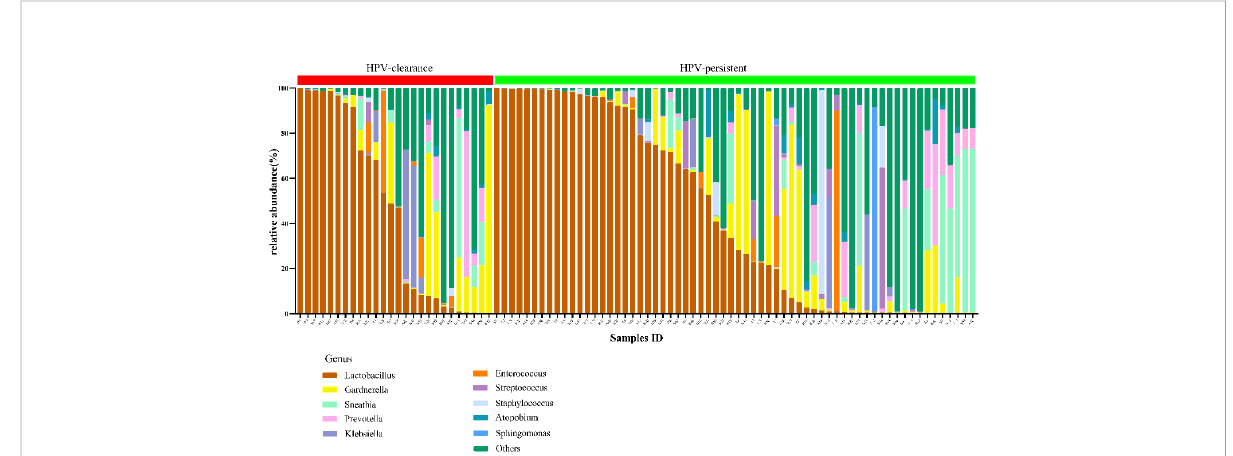
FIGURE 12 Vaginal fl ora at the genus level of HPV-cleared (n = 26) and HPV-persistent (n = 64)